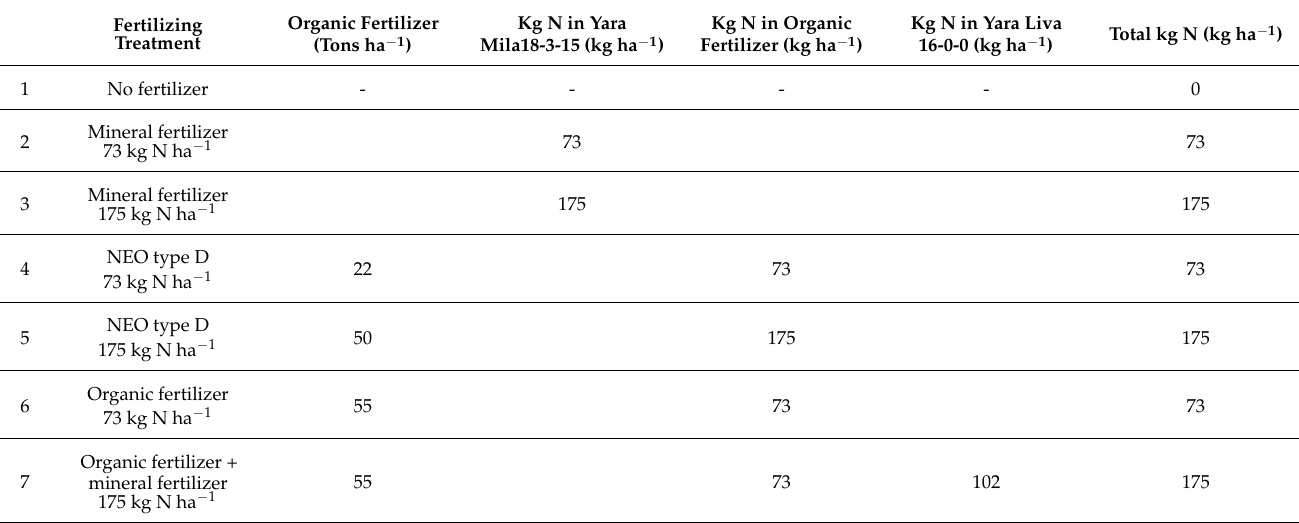
Table 1. Fertilizing treatments and application rates used in the growing chamber trial. Fertilizing